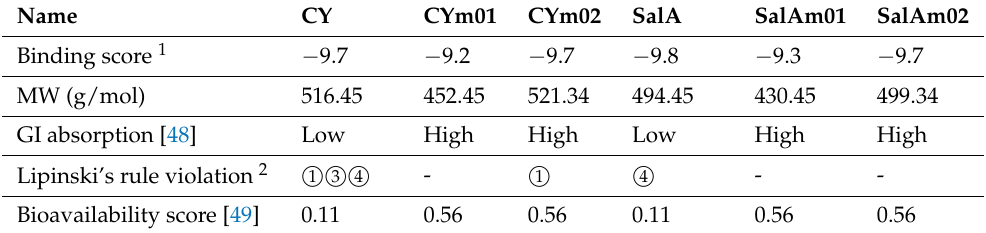
Table 6. Cynarin and SalA Derivative with the prediction of ADME parameters.